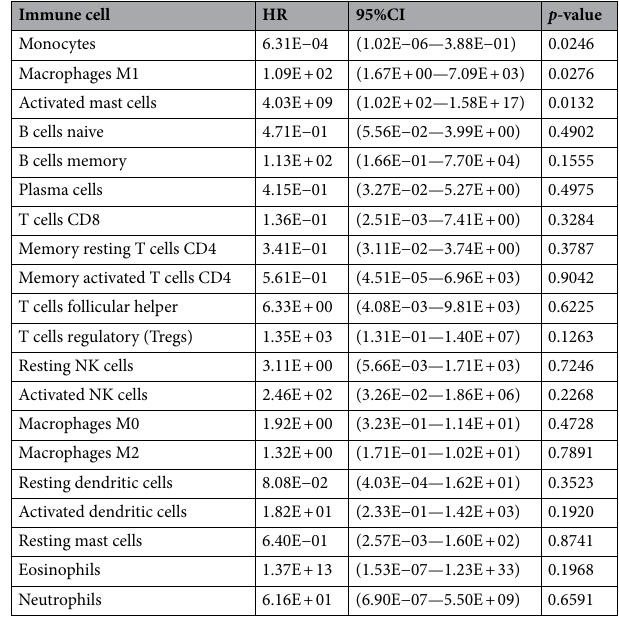
Table 2. Univariate cox hazards regression analysis of immune cells. HR hazards regression, CI confidence